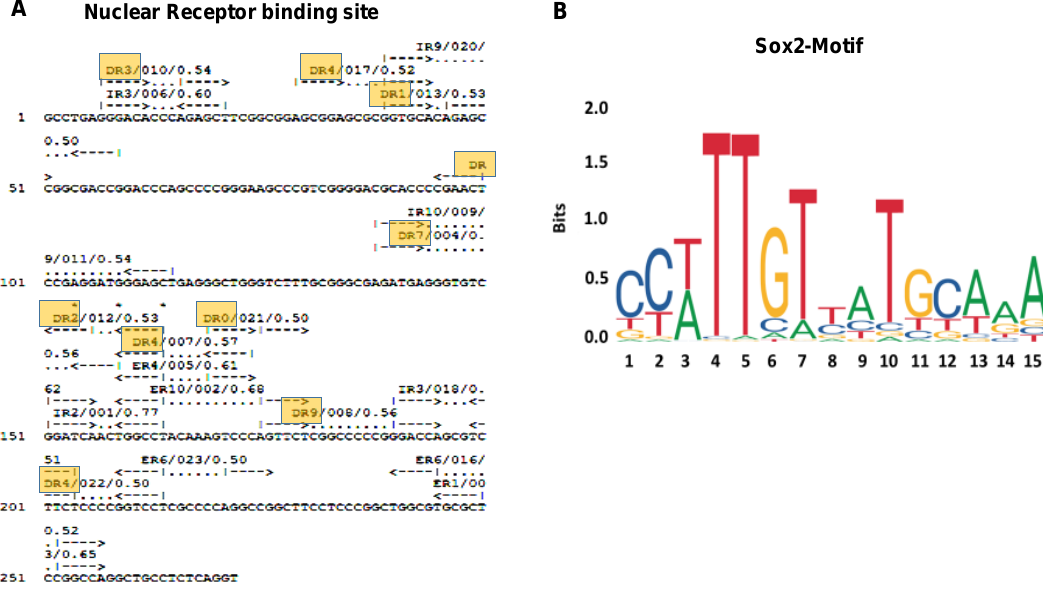
Figure 2. Transcription factor binding on miR193a promoter. ( A ). DR1, DR3 and DR4 elements for nuclear receptor binding. ( B ). Sox2 motif on the miR193a gene.